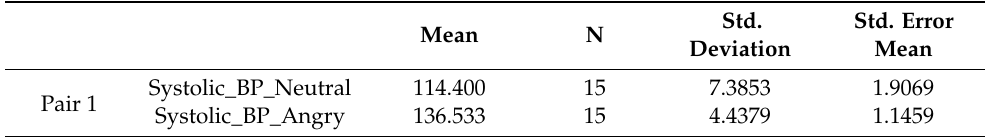
Table 8. Paired samples statistics for systolic BP (neutral to angry state).